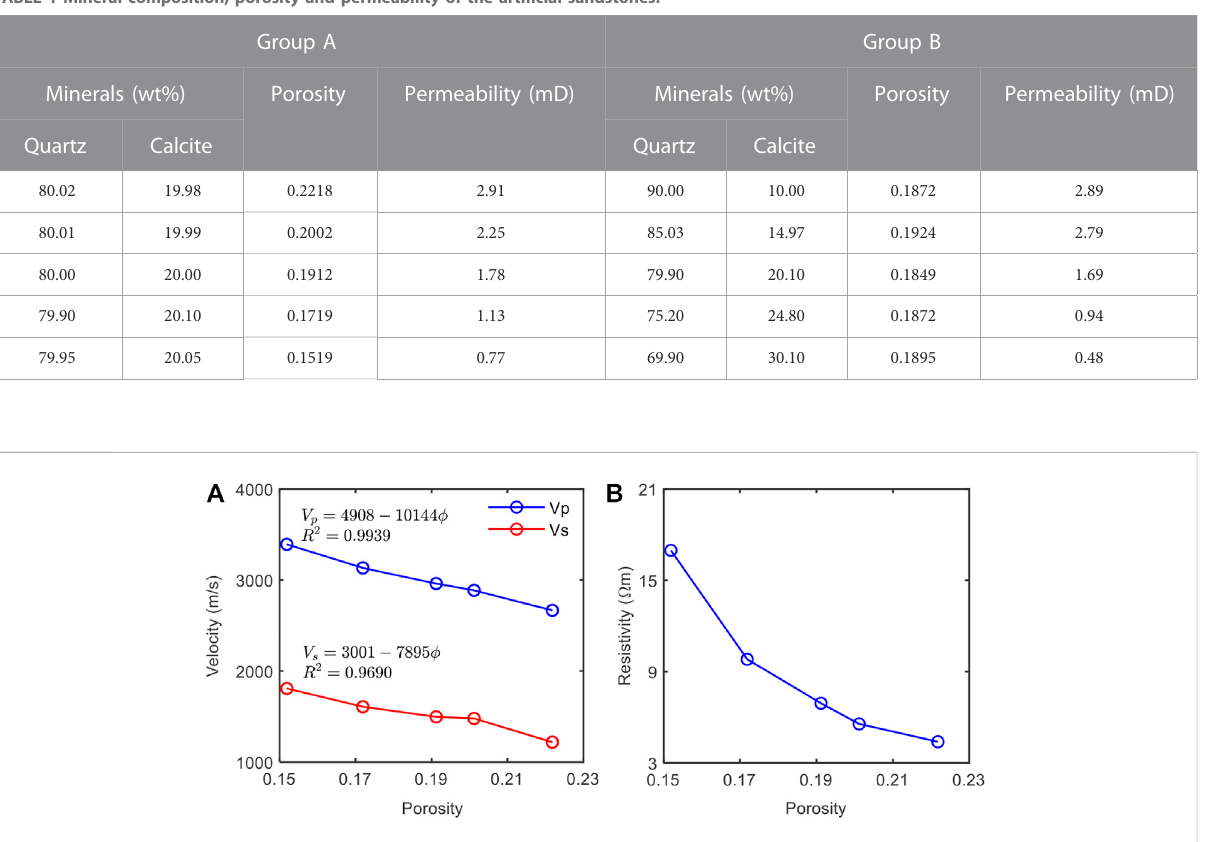
Effects of porosity on (A) the P- and S-wave velocities and (B) resistivity of the arti fi cial samples with the same amount of calcite